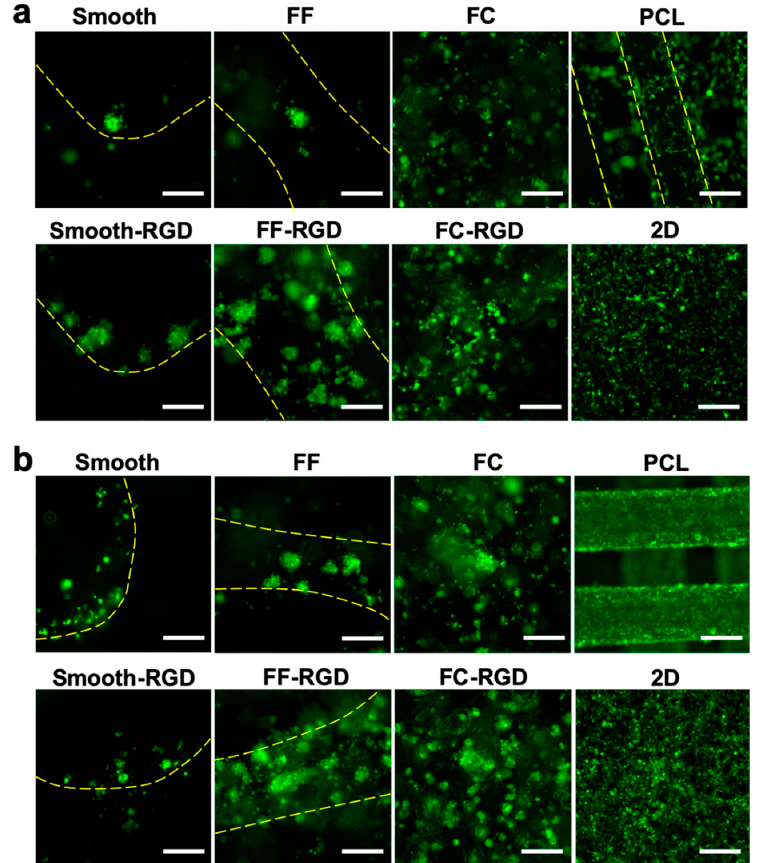
Figure 9. MDA-MB-231 cell distribution on FF scaffolds. Fluorescence images of smooth, FF, FC, and PCL scaffolds and 2D surfaces at 3 d ( a ) and 7 d ( b ). Yellow lines indicate the struts of printed scaffolds. Scale bars are 250 μ m.